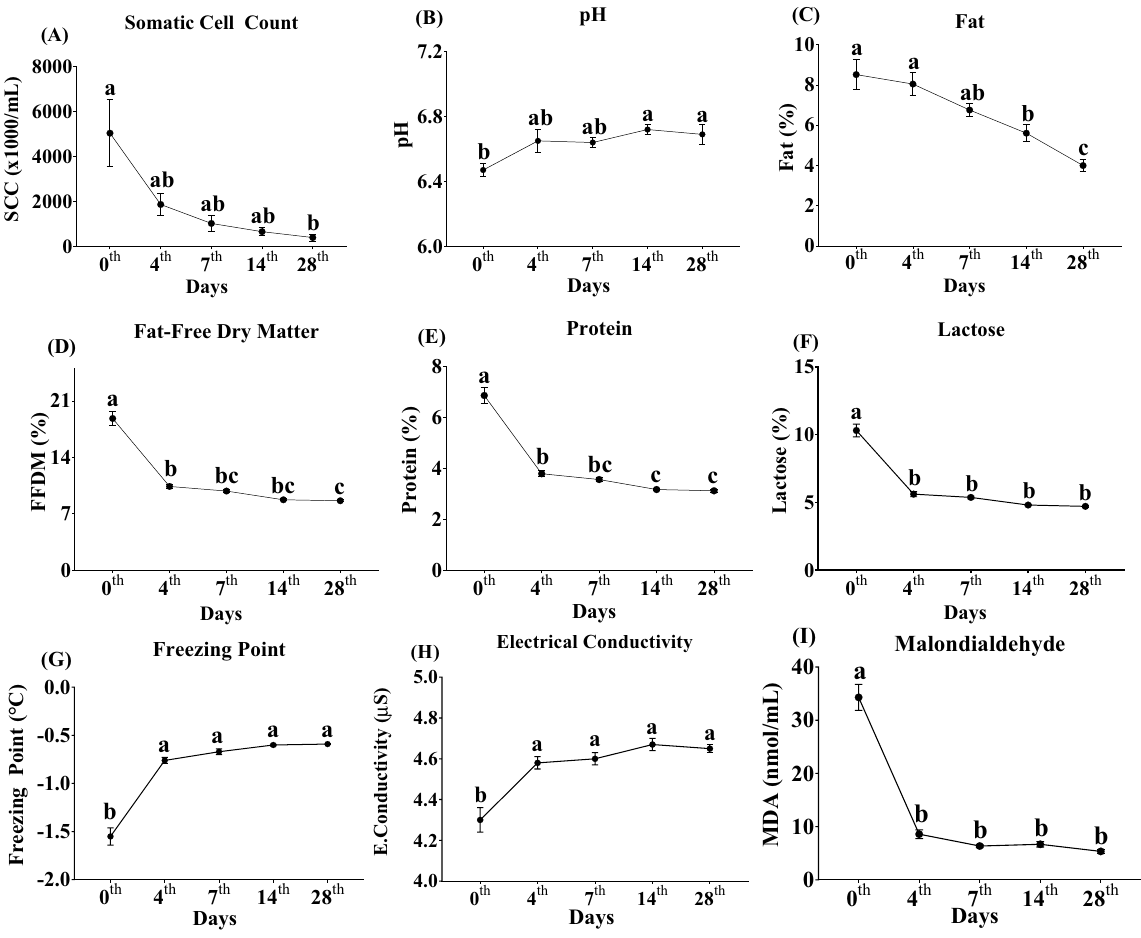
Figure 1. Somatic cell count, pH and compositional parameters on sampled days (Mean ± SEM); ( a – c ) Means followed by different letters differ significantly; SCC: Somatic cell count; FFDM: Fat-free dry matter; E. Conductivity: Electrical conductivity; MDA: